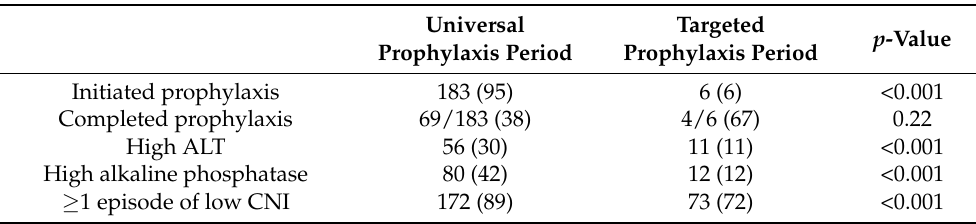
Figure 1. Cause of premature discontinuation of universal voriconazole prophylaxis among lung transplant recipients. Bar plot displays the distribution of side-effects leading to discontinuation as reported by clinicians. Percentage of side-effects shown are proportions of all patients discontinuing universal voriconazole prophylaxis. Table 2. Number (%) of lung transplant recipients with adverse events during the first 120 days after transplantation in the universal- and targeted antifungal prophylaxis